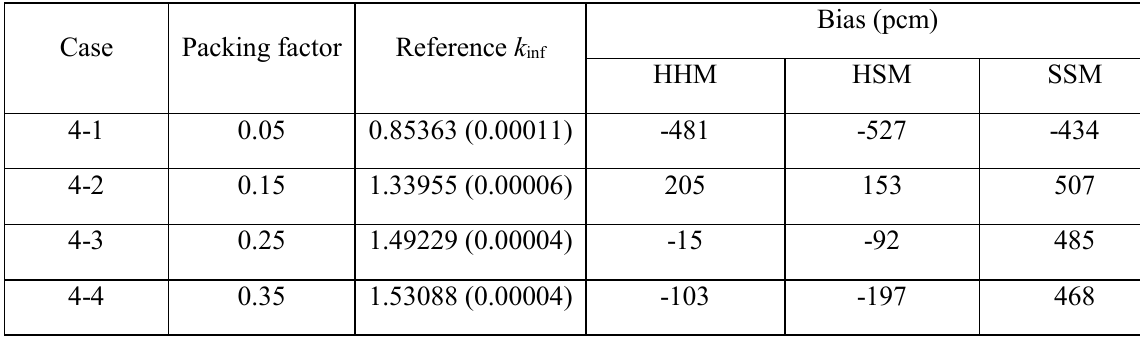
for cases with big TRISO particle inf